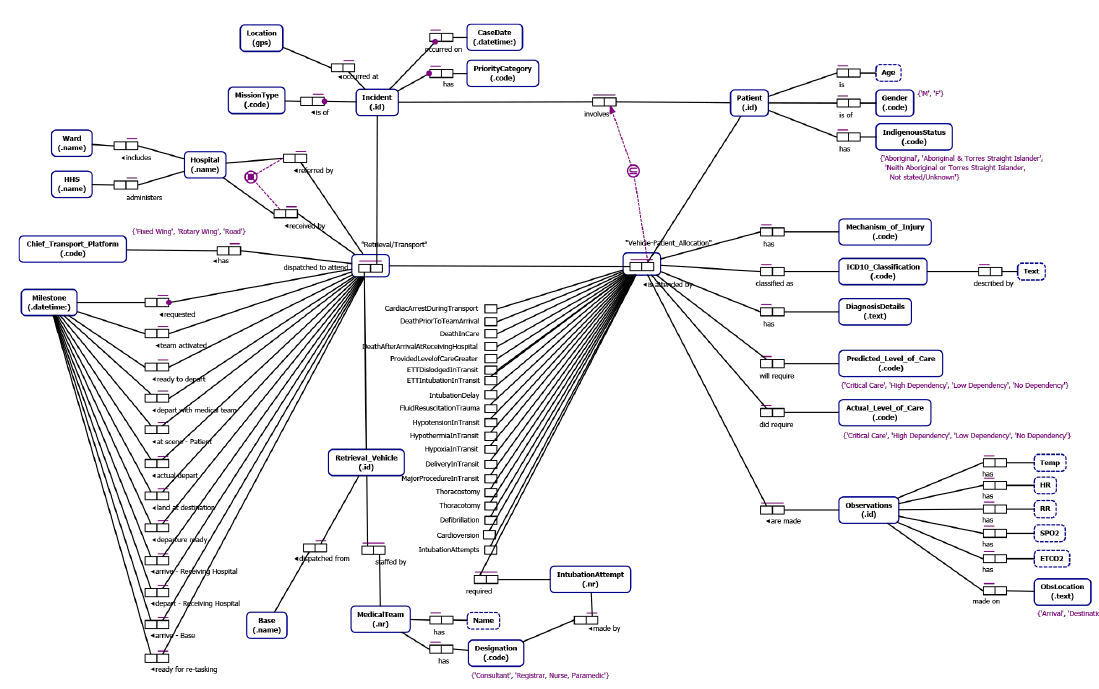
Figure 7. ORM model of RSQ